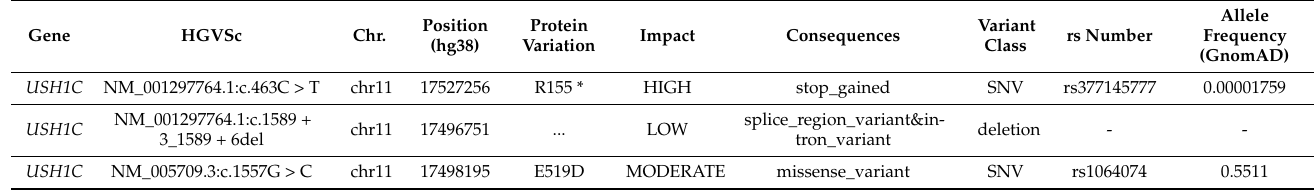
Table 3. USH1C variants of patient P5. Three variants detected via WGS analysis.